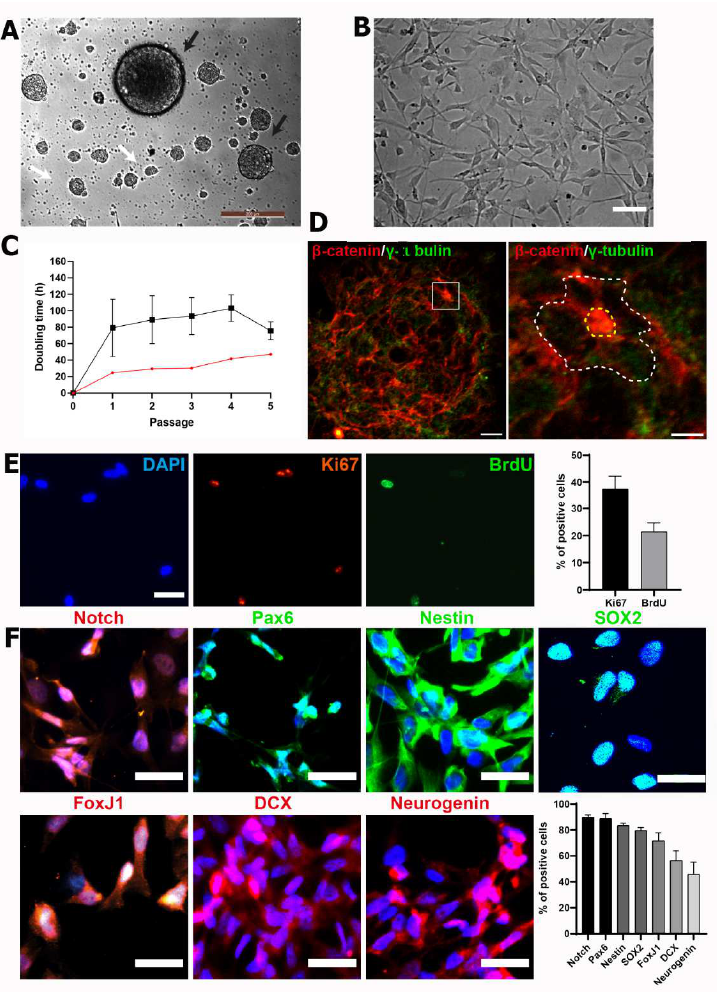
Figure 2. hfNPCs display proliferative potential and express canonical NPC markers in vitro. ( A ) Phase contrast image from hfNPCs as neurospheres-like cultures forming primary (black arrows) and secondary (white arrows) neurospheres as a hallmark of self-renewal in the presence of mitogens at passage 1. Scale bar = 200 µ m. ( B ) Representative phase contrast image of hfNPC culture in adherent conditions in laminin-coated wells when cultured at passages 2–5 (Scale bar = 20 μm). ( C ) Doubling time ( t ) analysis of hfNPCs (black line; data presented as the mean ± SEM ( n = 5 samples)) and one rat fetal NPC sample (red line) growing in adherent conditions over five passages. ( D ) The pinwheel cytoarchitecture (indicated with a white dotted line) of hfNPC at passage 1 from neurosphere-like cultures is highlighted after β -catenin (red; delimiting the cell perimeter) and γ -tubulin (green; for cilia detection) staining (scale bar = 20 µ m (left panel) and 10 µ m (right panel)). ( E ) Representative images from nuclear staining of DAPI (blue), Ki67 (red), and BrdU (green) of hfNPCs in adherent conditions (scale bar = 10 µ m). Right panel: Quantification of the percentage of positive cells for BrdU and Ki67. Data presented as the mean ± SEM ( n = 3 samples). ( F ) Left panel: Representative images of immunofluorescent staining for Notch, Pax6, Nestin, Sox2, FoxJ1, DCX, and neurogenin (scale bar = 20 µ m). Right panel: Quantification of the percentage of positive cells for each canonical neural progenitor cell marker. Data presented as the mean ± SEM ( n = 5